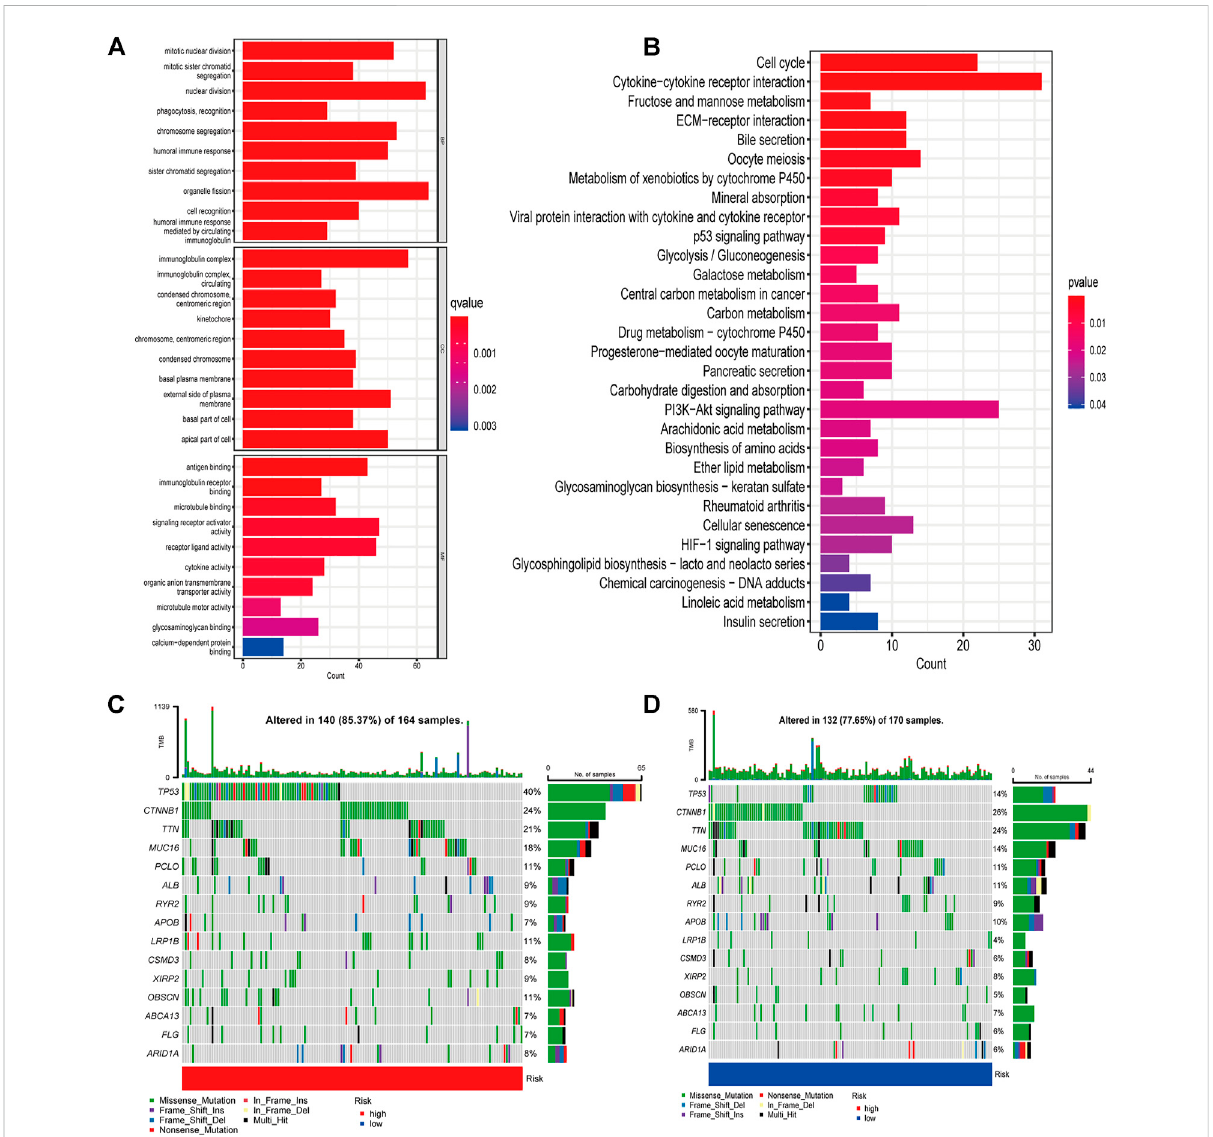
FIGURE 5 GeneenrichmentandTMB inhigh-and low-risk groups (A) GOenrichmentanalysis (B) KEGGenrichmentanalysis (C) Waterfallplots displaying the mutation landscapes of the low-risk group. (D) Waterfall plots displaying the mutation landscapes of the high-risk group. TMB, tumor mutation burden; GO, Gene Ontology; KEGG, Kyoto Encyclopedia of Genes and Genomes; BP, Biological process; CC, Cellular component; MF Molecular